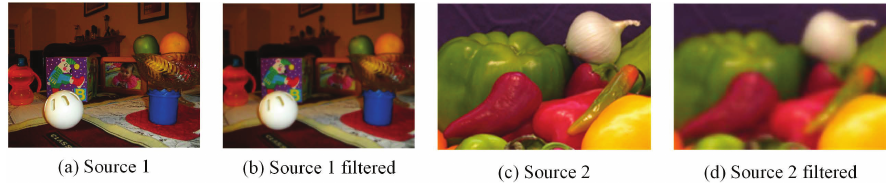
Figure 4. Two source images and the filtered images via the guided filter. The guidance images are the source images themselves, and parameters r and (cid:101) are set to three and 0.16,